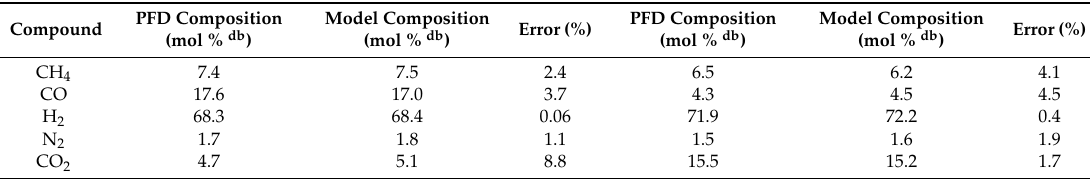
Table 5. Validation of the reformer and shift